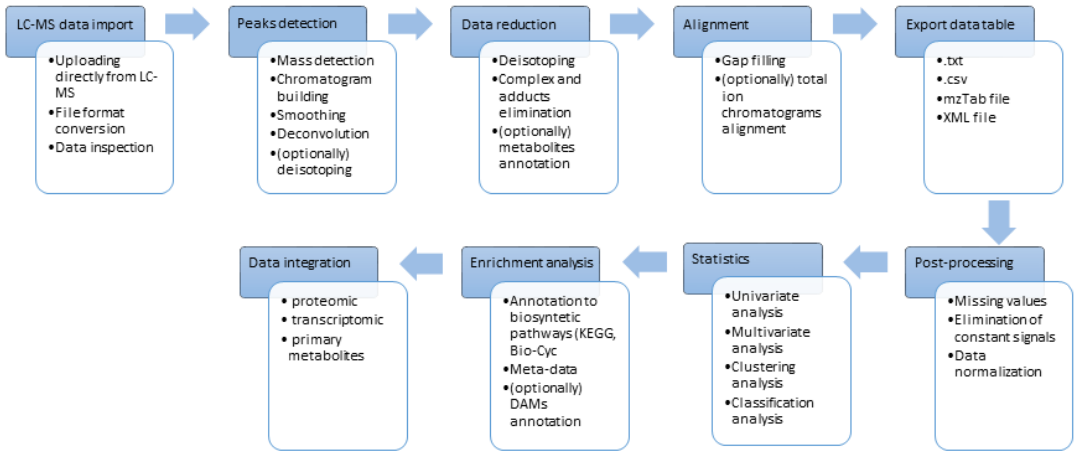
Figure 3. Scheme of workflow in metabolomics data processing, post-processing and statistics in